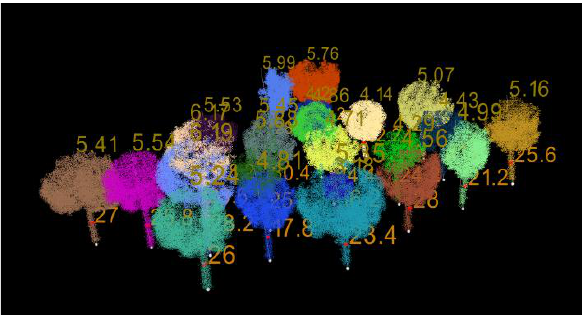
Figure 8 . Measurement of DBH and Height from HMSL data in the 3D Forest for entire study area